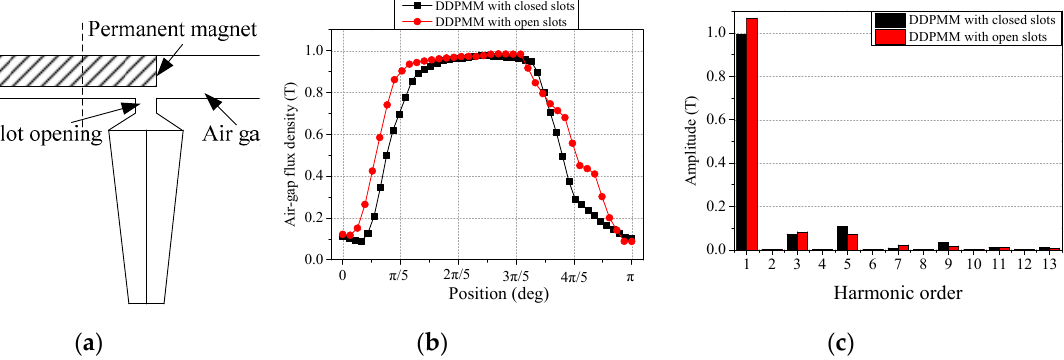
Figure 7. Magnetic field analysis at position 3: ( a ) position 3; ( b ) air-gap flux density waveforms; ( c )